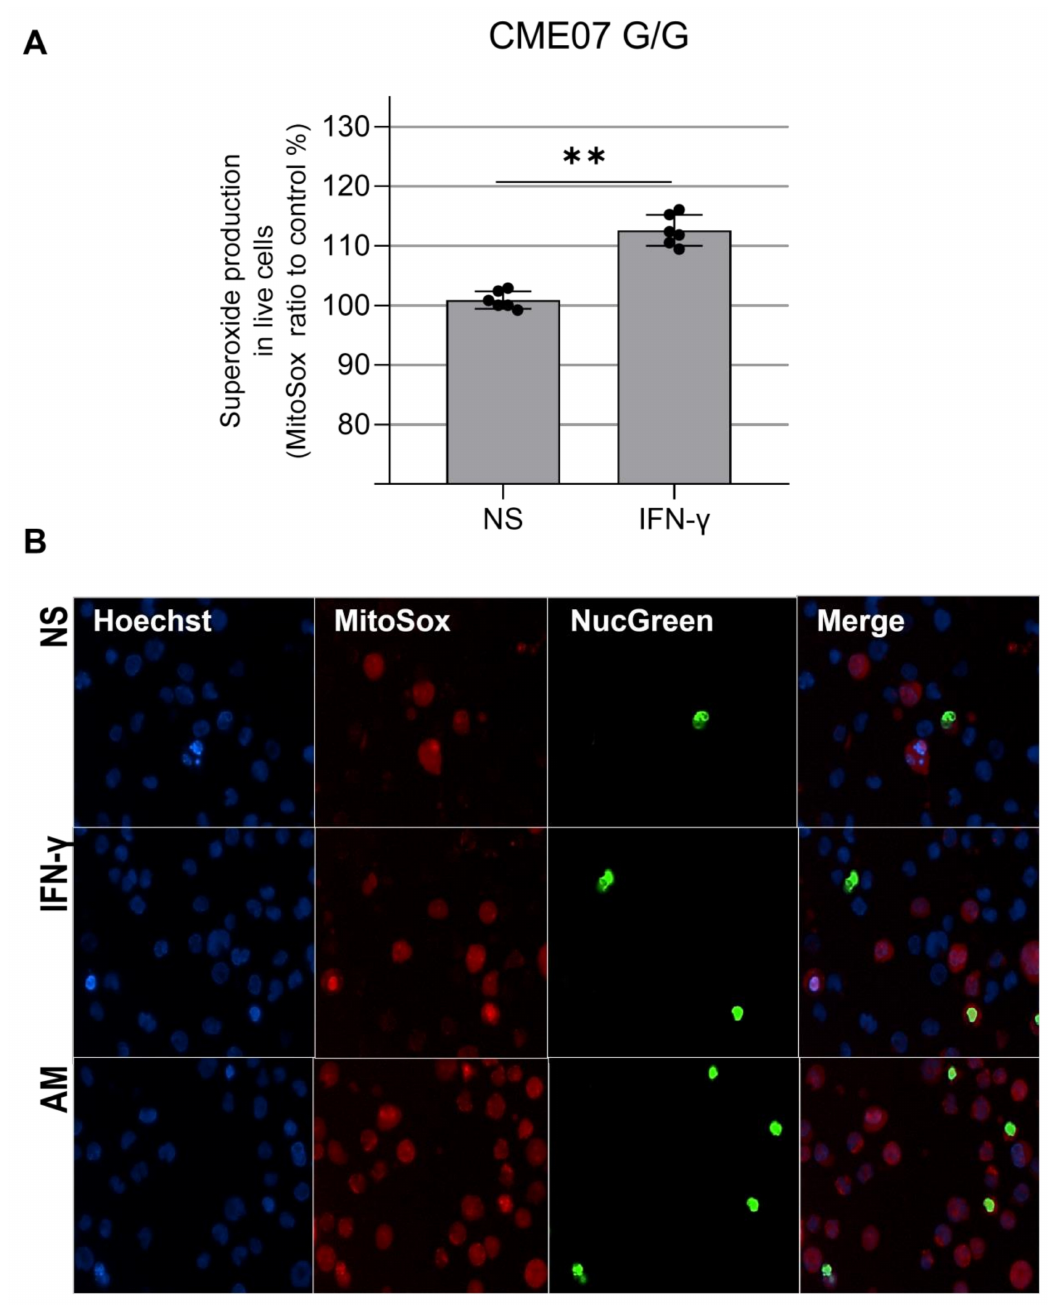
Figure 4. ( A ) . Mitochondrial ROS increase in IFN- γ -treated EBV-LCL from CME07 (homozygous MRPS18B G/G). A total of 15 × 10 4 EBV-LCL cells were stimulated with IFN- γ 25 ng/mL for 24